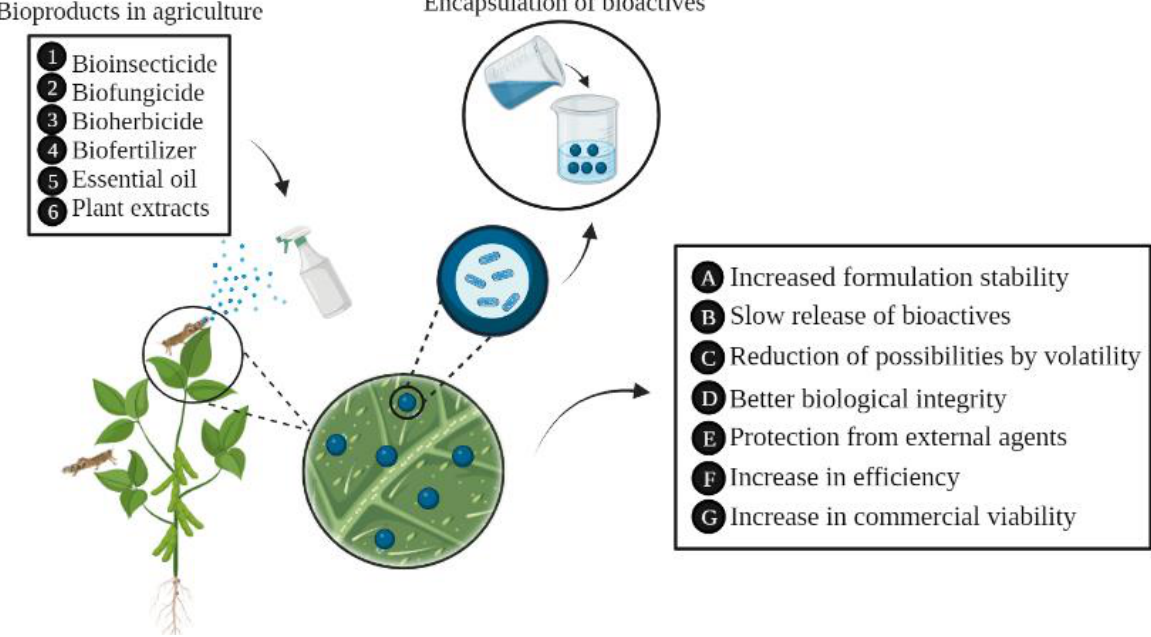
Figure 3. Advantages and applications of encapsulation in the agricultural sector.